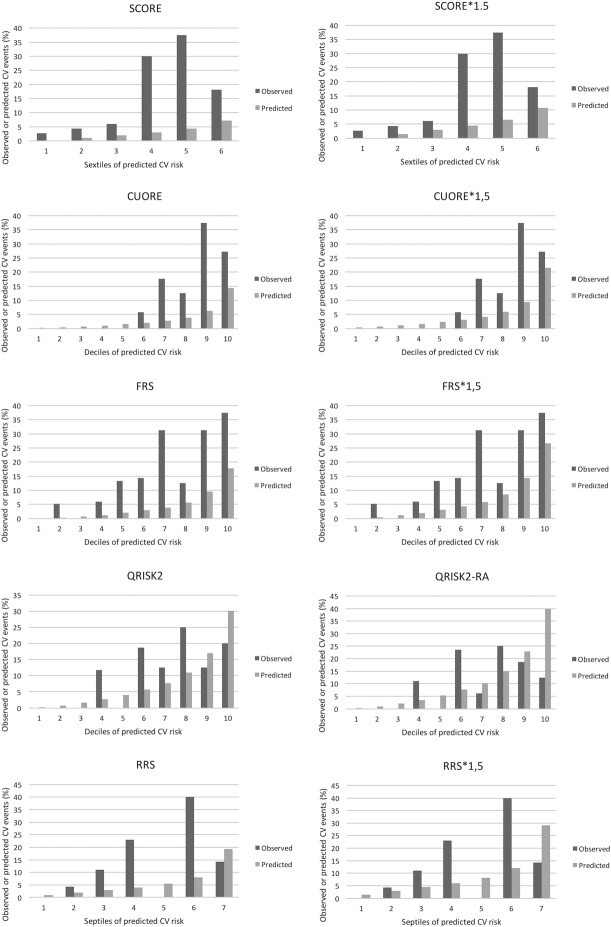
Observed versus predicted risk.Observed (dark grey bars) vs predicted (light grey bars) CV events (%) in deciles, sextiles, and septiles for SCORE (A), SCORE*1.5 (B), CUORE (C), CUORE*1.5 (D), FRS (E), FRS*1.5 (F), QRISK2 (G), QRISK2-RA (H), RRS (I), and RRS*1.5 (L).